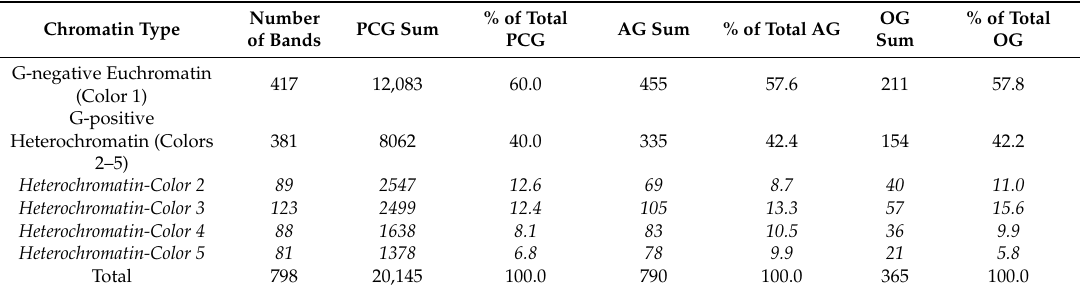
Table 3. Summary data of chromosome bands and genes by group for each chromatin